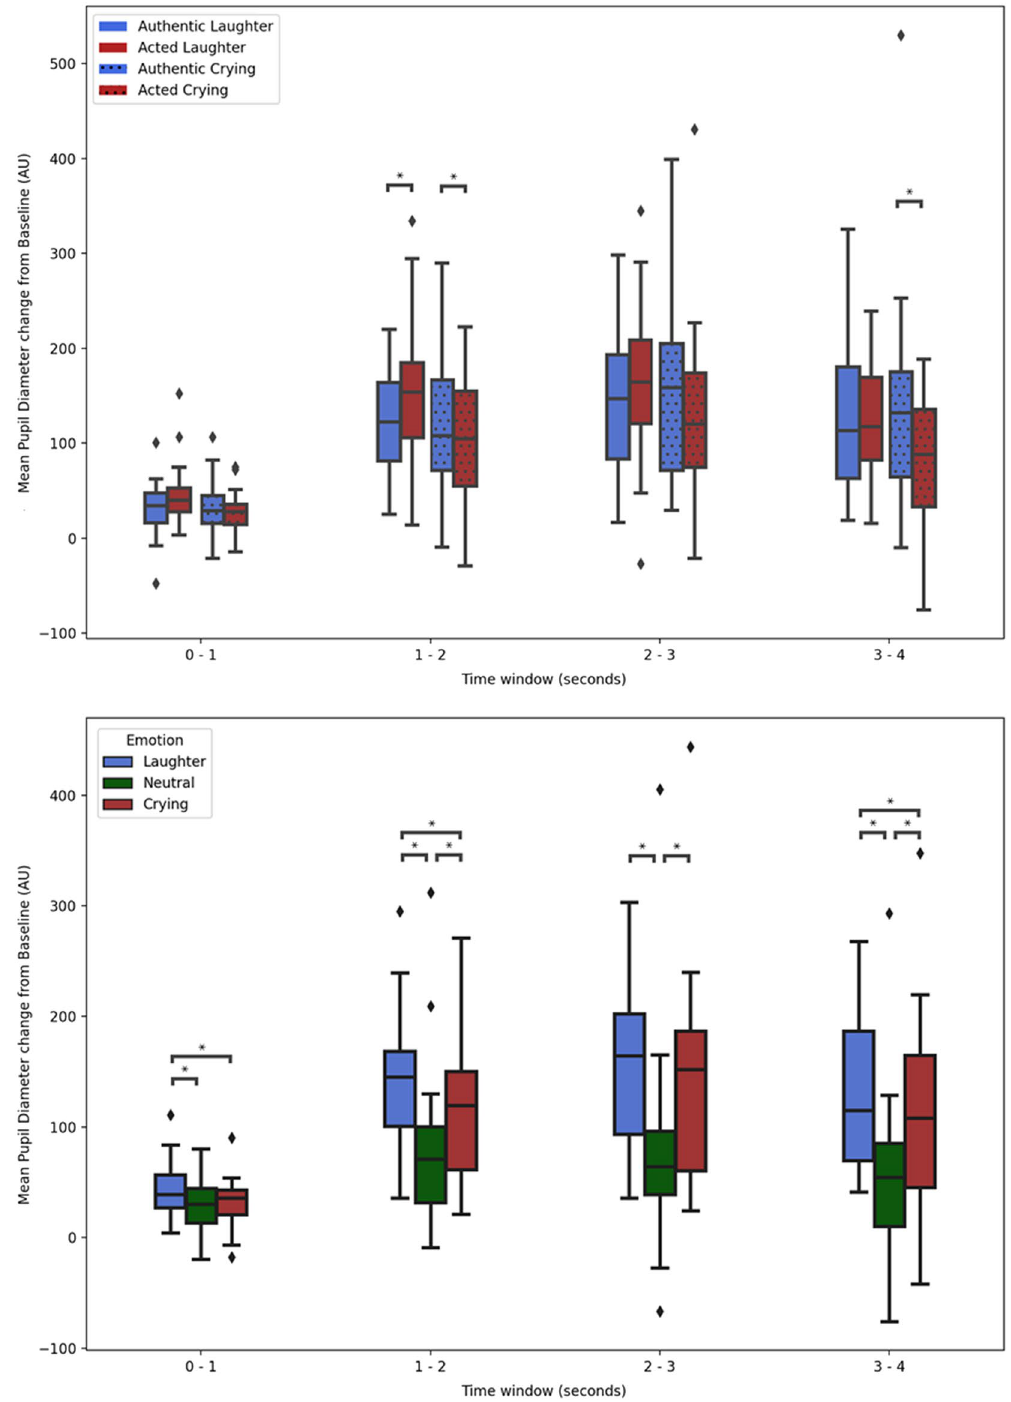
Figure 3. Box plots of mean pupil diameter as a function of authenticity per emotion, showcasing the authenticity by emotion interaction (above) and of mean pupil dilation as a function of emotion showcasing the main effect of emotion (below)—both for each time window (seconds). Statistically significant ( p < .05, after FDR correction) pairwise comparisons are highlighted with an *. Error bars represent ± 1.5 SD; AU = Arbitrary